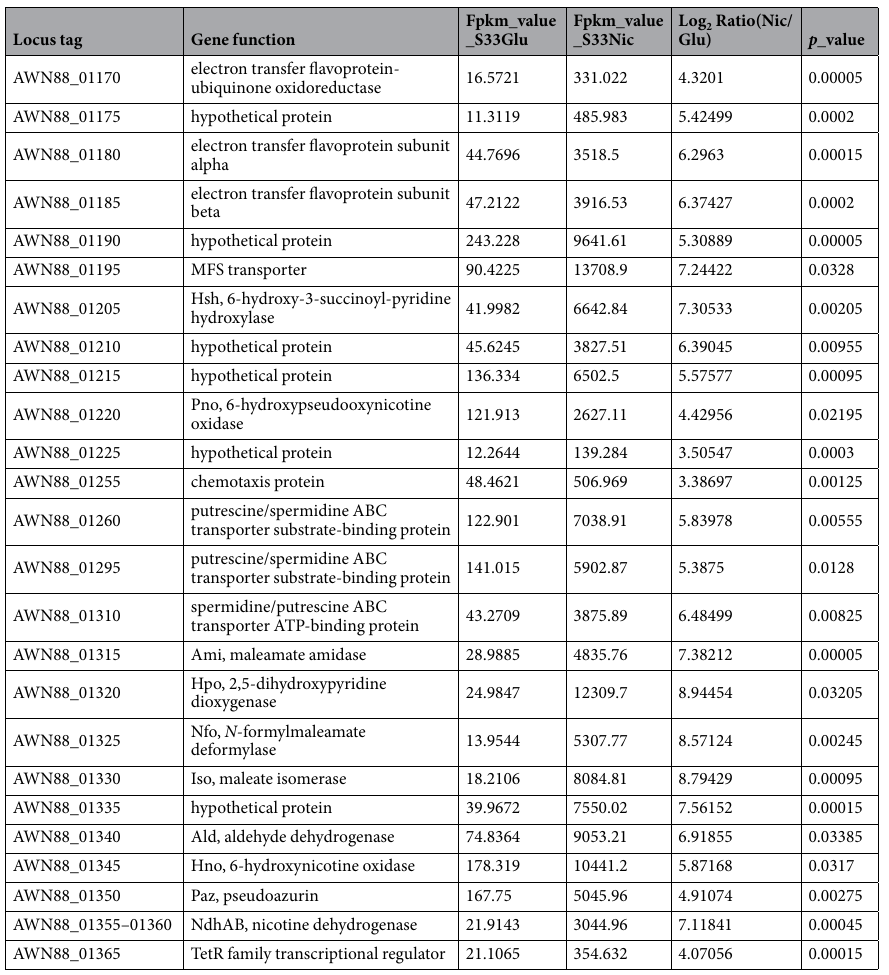
Table 1. Differently up-regulated genes in the nicotine-degrading gene cluster when A . tumefaciens S33 grows on nicotine compared to on glucose and ammonium